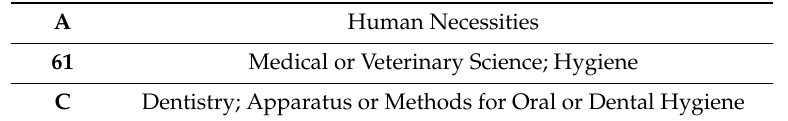
Table 4. International Patent Classification (IPC) class hierarchy.